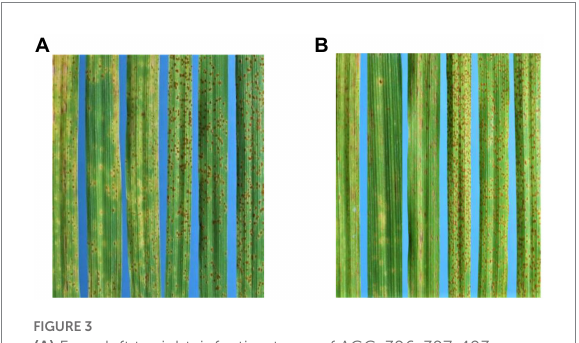
FIGURE 3 (A) From left to right, infection types of AGG-396, 397, 403, PI584760, Bowman + Rph14 , and Bowman, respectively, with 5610 P+. (B) Infection types of AGG-396, 397, 403, PI584760, Bowman + Rph14 , and Bowman, respectively, with 210